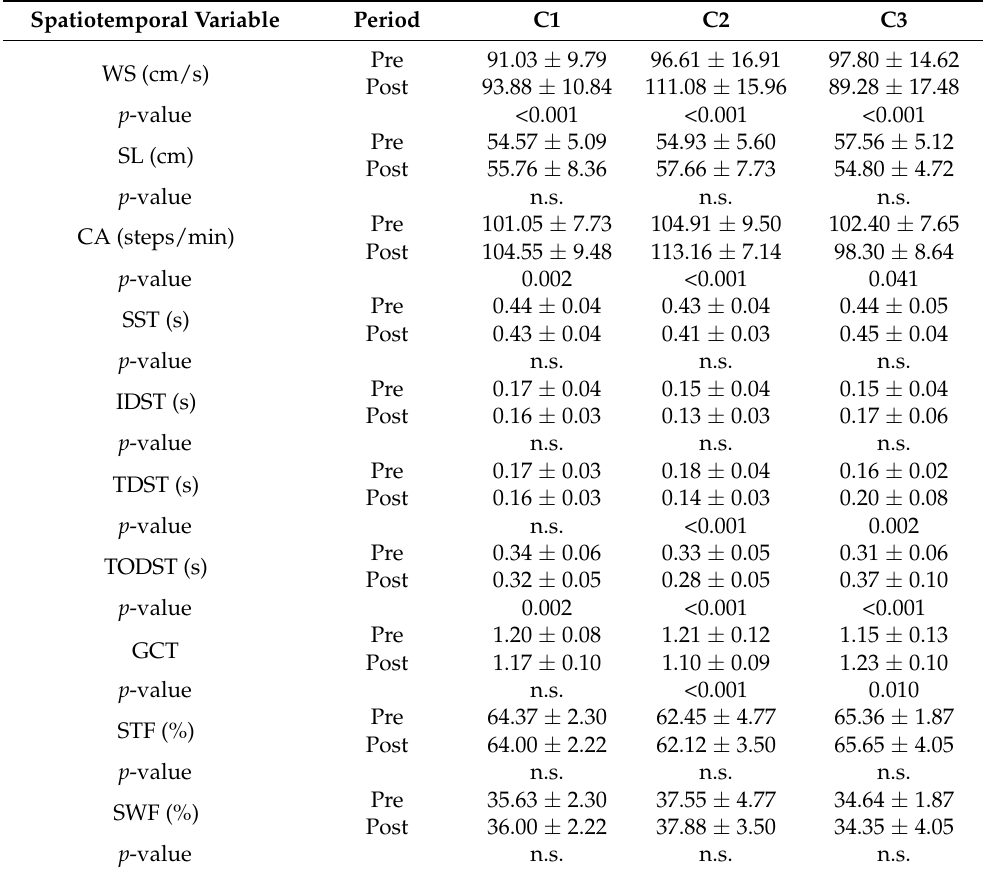
Table 2. Spatial and temporal data for pre- and post-steering gait (data reported in the mean ± standard